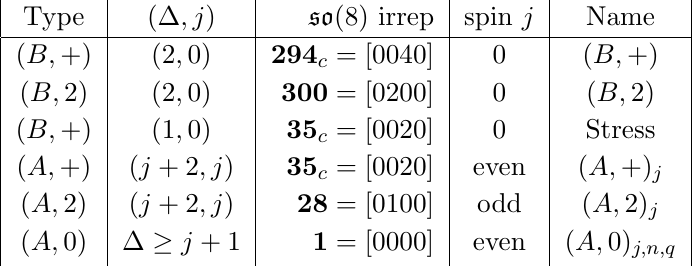
Table 2 . The possible superconformal multiplets in the O Stress (cid:2)O Stress OPE. The so (3 ; 2) (cid:8) so (8) quantum numbers are those of the superconformal primary in each